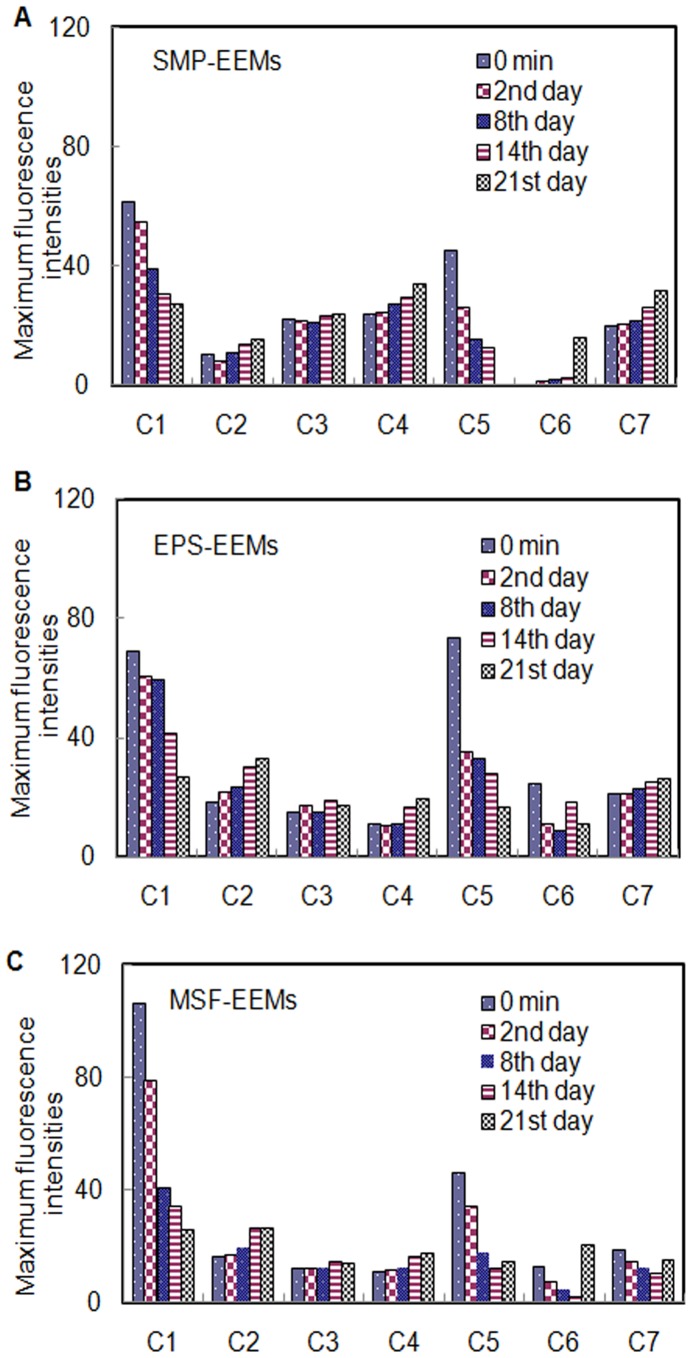
Microbial transformation of the maximum fluorescence intensities (Fmax) of the PARAFAC components in the SMP-EEMs, EPS-EEMs and MSF-EEMs.